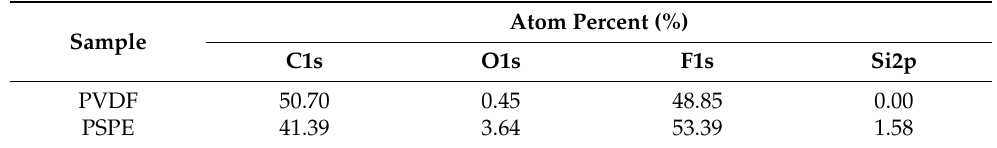
Figure 2. ( a ) FTIR spectra and ( b ) XPS spectra of PVDF and PSPE film. FE-SEM and AFM image of ( c - i , ii ) PVDF film surface and ( c - iii , iv ) PSPE film surface. Table 1. Elemental compositions of PVDF and PSPE